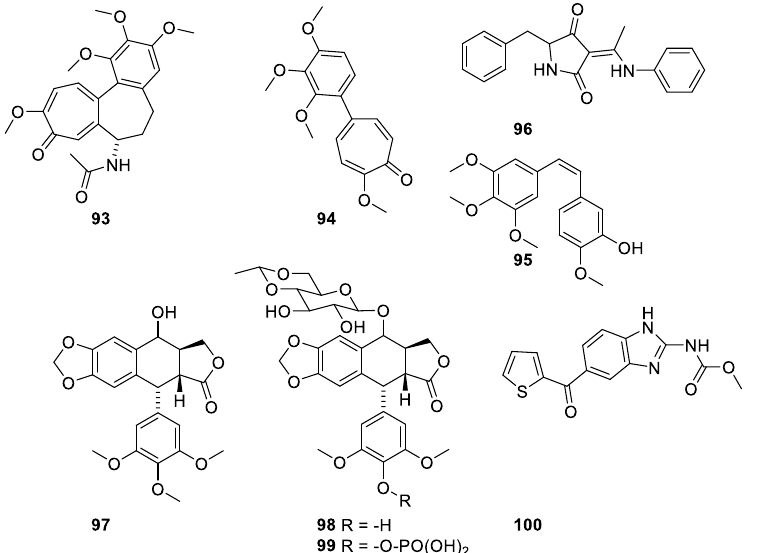
Figure 26. Compounds with affinity for the colchicine domain in tubulin. Colchicine ( 93 ), the col- chicine pharmacophore 2-methoxy-5-( 2′ , 3′ , 4′ -trimethoxyphenyl)tropone ( 94 ) and combretastatin CA-4 ( 95 ), TN-16 ( 96 ), podophyllotoxin ( 97 ), etoposide ( 98 ), etopophos ( 99 ) and nocodazole ( 100 ) [92].